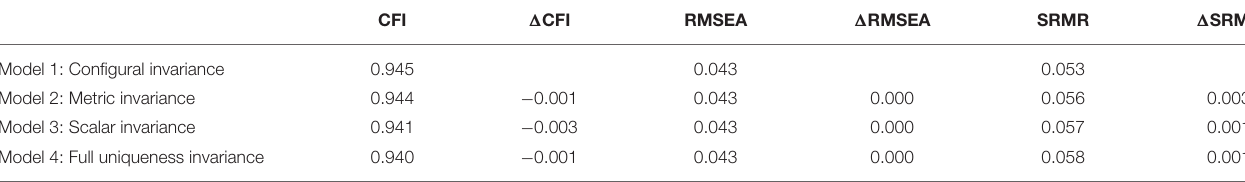
TABLE 6 | Model fit for the different levels of post-transition measurement invariance over time. CFI 1 CFI RMSEA 1 RMSEA Model 1: Configural invariance Model 2: Metric